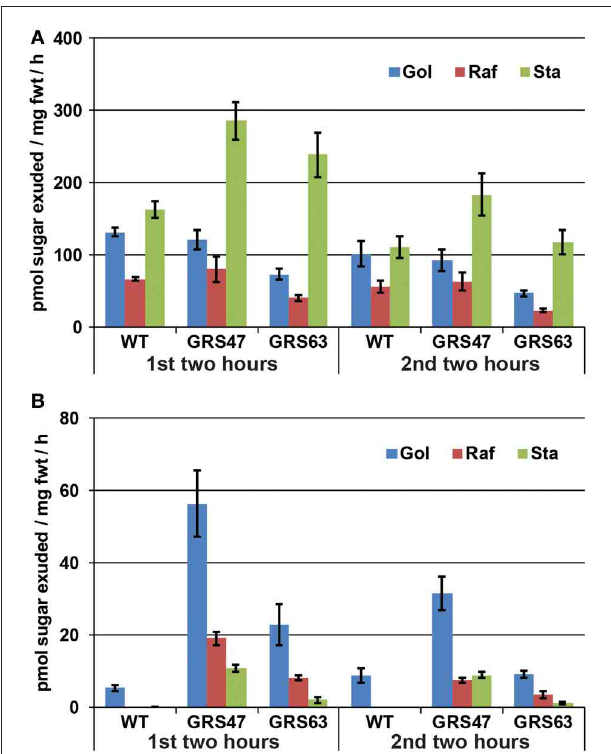
FIGURE A1 | Soluble carbohydrates in phloem exudates from wild type and transgenic plants. This representative experiment is similar to that presented in Figure 4 except that they were conducted on 16 d-old whole rosettes with only the cut hypocotyl in EDTA to minimize exposure during exudations. In addition, EDTA was reduced to 5mM. Similar to other exudation experiments, exudations were performed in dim conditions and 100% humidity to minimize EDFTA uptake through the xylem. (A) Exudation rates for Glc, Fru, and Suc. (B) Exudation rates for Gol, Raf, and Sta. Note the difference scales of the Y axis between (A) and (B) . Variation is expressed as SE; n = 6 sibling